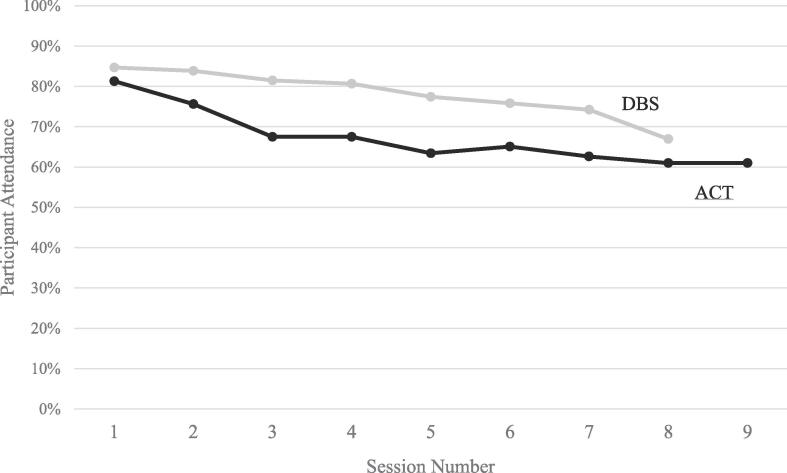
Percentage of participants attending each session in DBS and ACT.